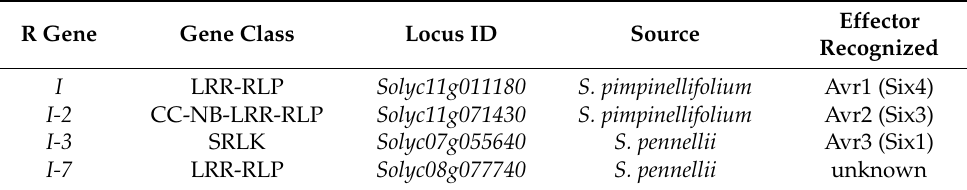
Table 1. Resistance genes introgressed from wild tomato species and their corresponding effectors of Fusarium oxysporum f. sp. lycopersici